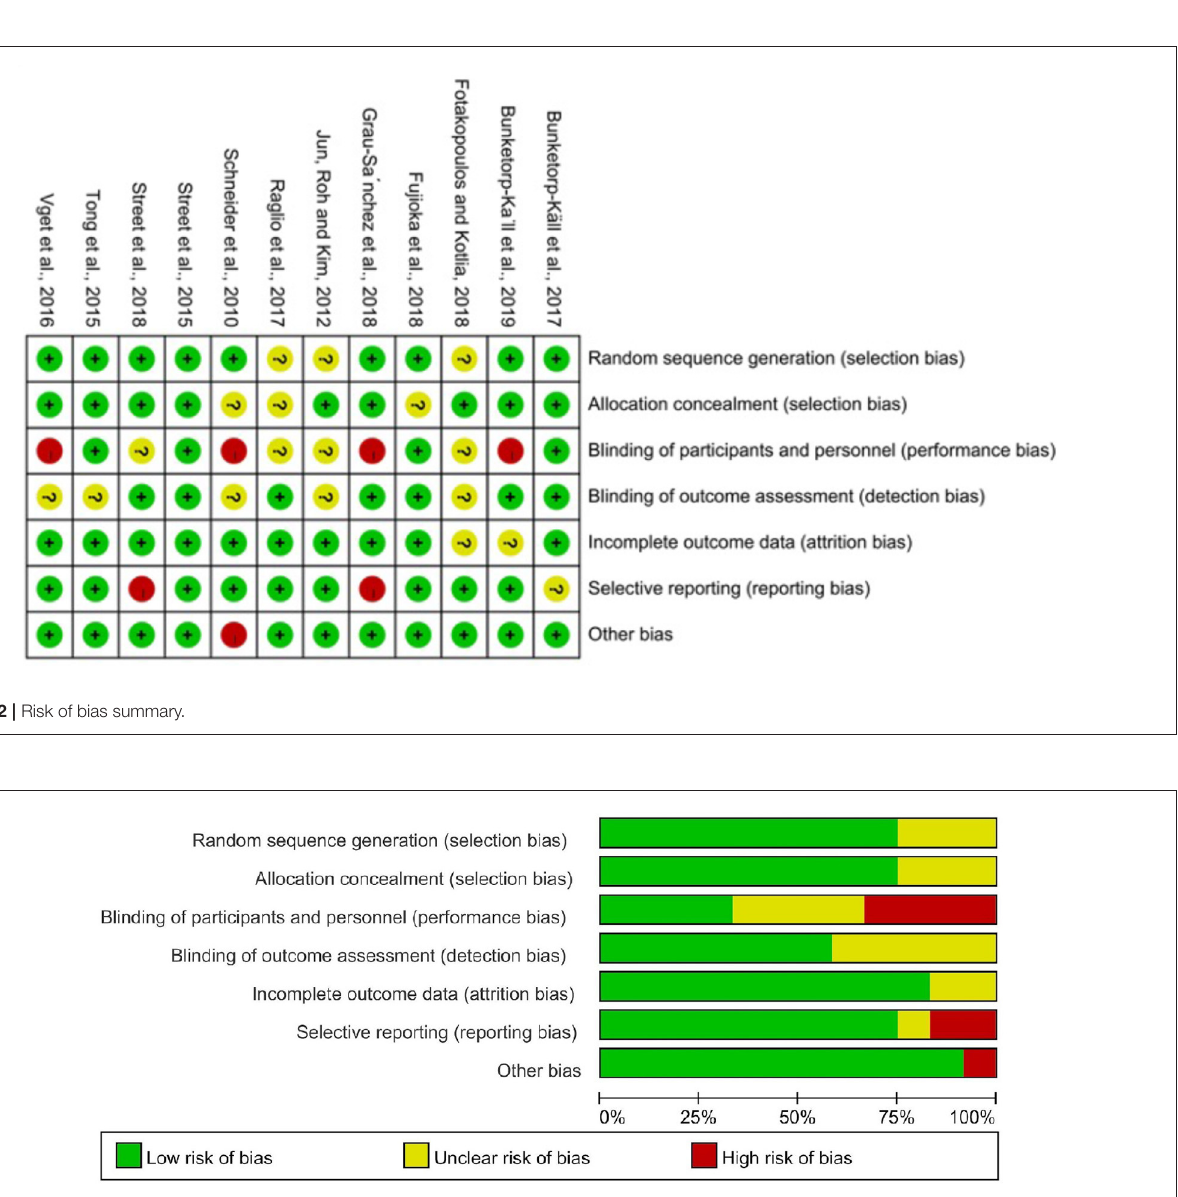
FIGURE 3 | Risk of bias